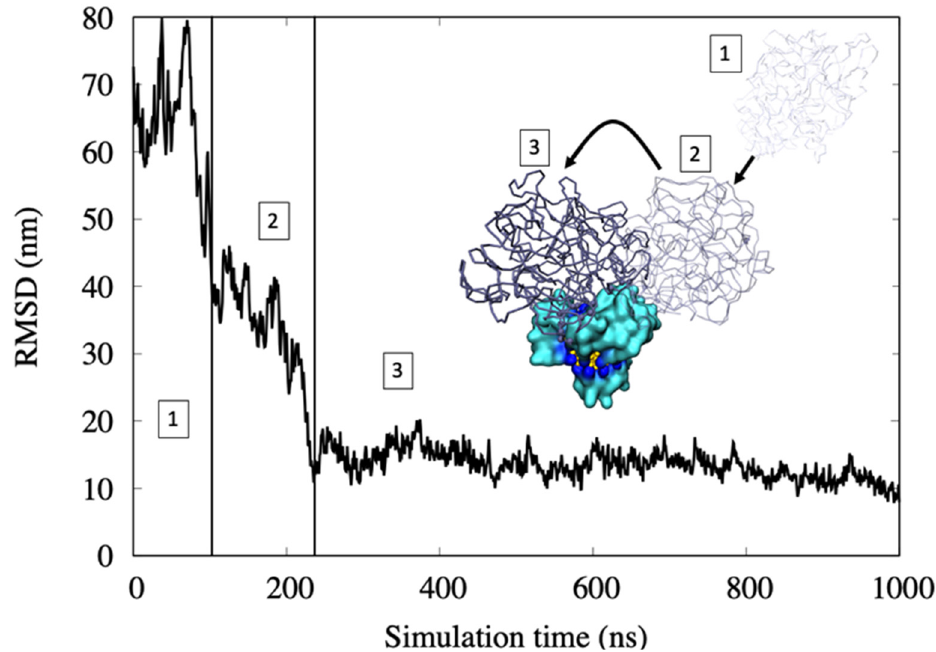
Figure 5. The Root Mean Square Deviation (RMSD) of the hemoglobin showing the three-steps of binding to AuNP. In step 1, the protein is far away from the AuNP. In step 2, the protein makes its first contact with the AuNP over the heads of the ligands. In step 3, the protein finds the most stable binding site.